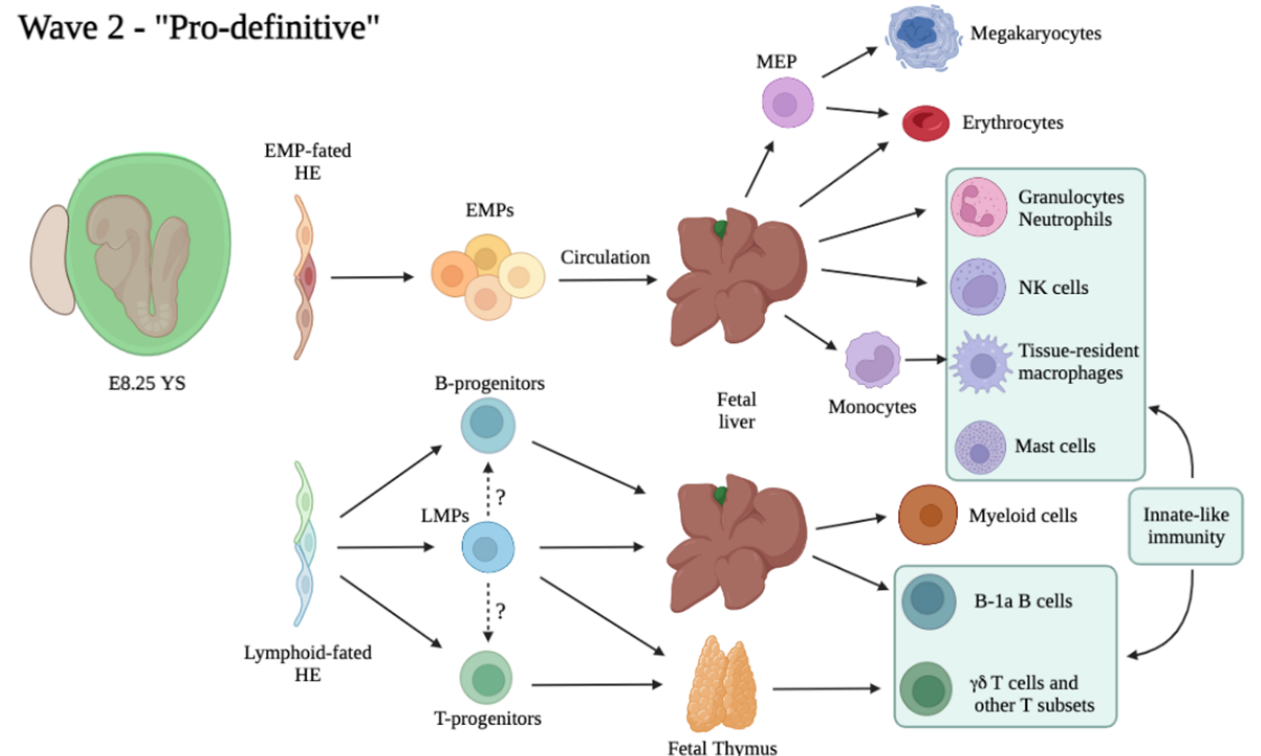
Figure 2. Proposed model of the second, or “Pro-definitive” hematopoietic wave. Dotted lines and “?” symbol indicate unclear lineage relationships between progenitors.